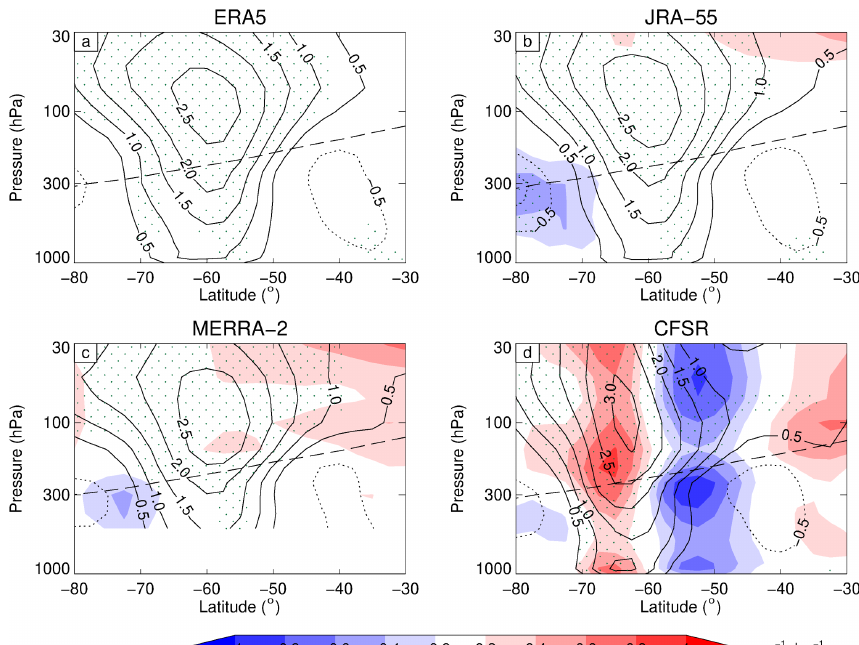
Figure 1. DJF trend of the zonally averaged zonal wind (contour intervals: ± 0.5, ± 1.0, ± 1.5, ± 2.0, ± 2.5, and ± 3.0ms − 1 per decade) from 1980 to 2001 for ERA5 (a) , JRA-55 (b) , MERRA-2 (c) , and CFSR (d) . The shading represents differences from ERA5 at intervals of ± 0.2, ± 0.4, ± 0.6, ± 0.8, and ± 1.0ms − 1 per decade. The dashed line shows the climatological tropopause level. Results in the range 500 to 1000hPa are not included in panel (c) . Stippling denotes regions where the trends are significant at the 5% significance